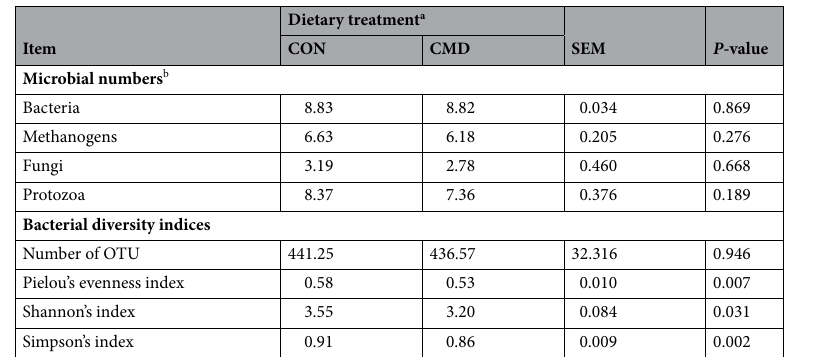
Table 5. Rumen microbial numbers and bacterial diversity indices in lambs fed concentrate diets containing dehydrated lucerne (CON) or cardoon meal (CMD). SEM pooled standard error of the mean, OTU operational taxonomic unit. a CON control diet, CMD cardoon meal diet. b Data were log-transformed to achieve normality and results expressed as log copy/mg DM of freeze-dried rumen